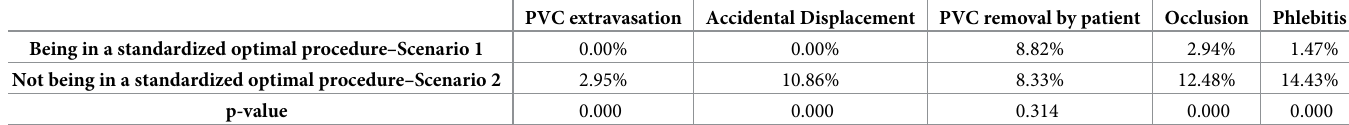
Table 3. A focus on the development of adverse events.